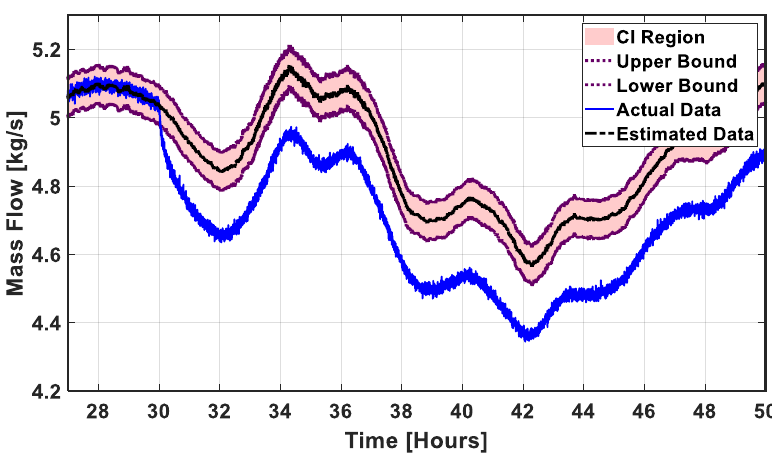
Figure 9. Testing of Hammerstein model with 5% leak at 30 h, 1201 parameters and 0.2% noise ratio.